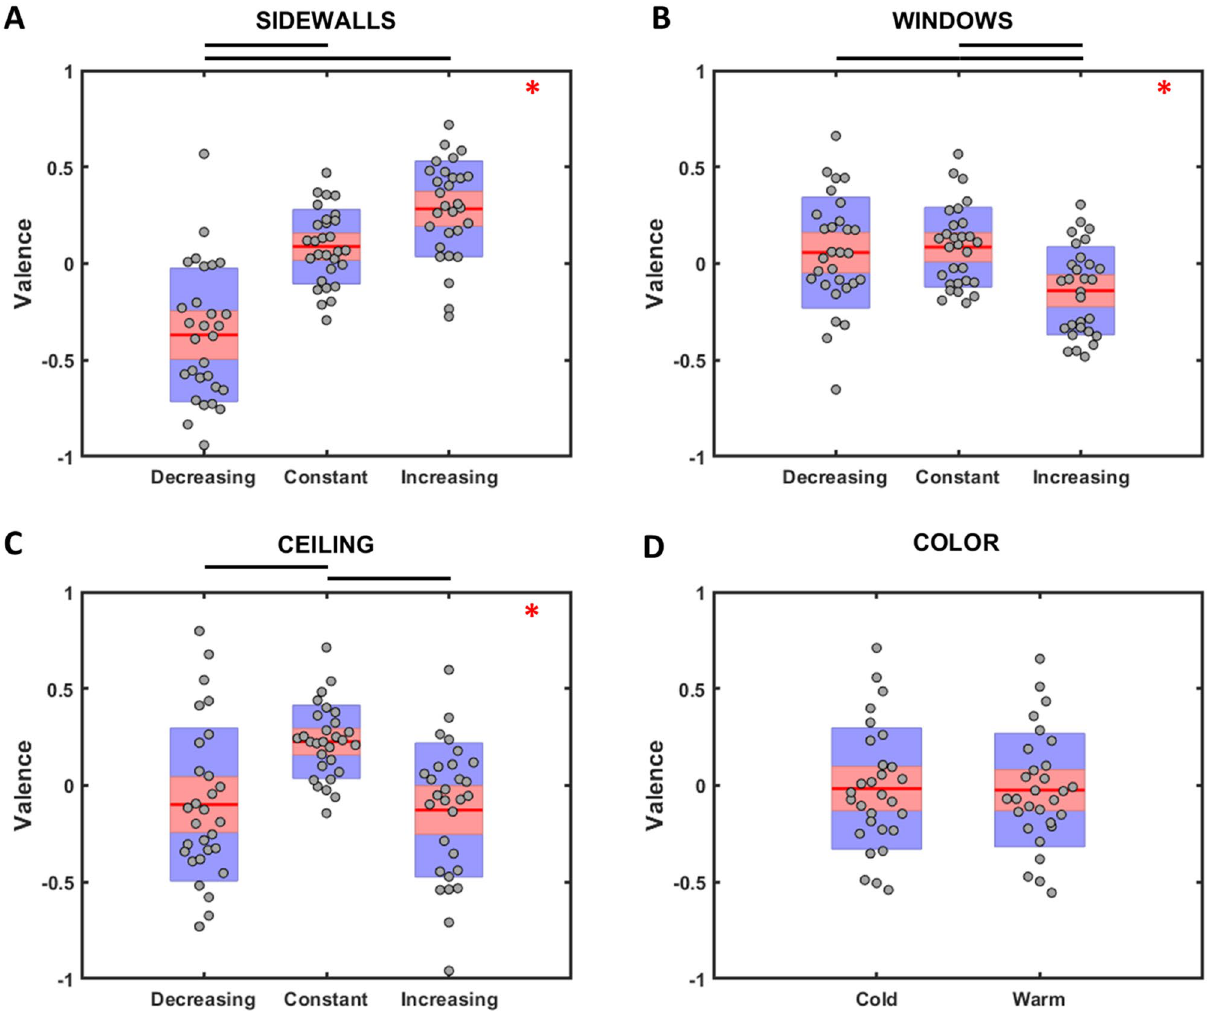
Figure 2. Distribution of the valence scores for SideWalls, Windows, Ceiling, and Color are presented in ( A – D ), respectively. Red lines represent the mean value; data are represented as dots laid over a 1.96 standard error mean (95% confidence interval) in pink and a 1 standard deviation in blue. Red asterisks indicate a significant main effect, and black lines show significant pairwise with different combinations concerning the sidewalls distance and ceiling height. Contrarily, those architectural designs with decreasing sidewalls distance and increasing ceiling height received significantly lower valence scores than those with different combinations of such architectural elements. Also the interaction Windows x Ceiling (F(4,112) = 3.297, p = 0.013, η p2 = 0.105) returned to be significant as presented in Fig. 3B. Specifically, Bonferroni corrected pairwise comparisons revealed that subjects provided significant lower valence scores for those designs with increasing windows height rather than decreasing (p = 0.022) or constant (p = 5 * 10 –5 ), but only when the ceiling of the environment increased between one nucleus and the next one, and not in the decreasing or constant ceiling height condition. Results of the rm ANOVA on arousal ratings are illustrated in Fig. 4. A significant effect was found for the main factors SideWalls (F(2,56) = 20.589, p = 1.9 * 10 –7 , η p2 = 0.424) and Windows (F(2,56) = 6.812, p = 0.002, η p2 = 0.196), with a trend for the factor Ceiling (F(2,56) = 2.519, p = 0.089). Specifically, Bonferroni corrected pairwise comparisons revealed that architectural designs with decreasing sidewalls distance resulted in higher arousal scores than those with constant (p = 2.2 * 10 –4 ) and increasing (p = 1.5 * 10 –7 ) sidewalls distance. Designs with increasing windows sill height were perceived as more arousing than those with constant (p = 0.029) and decreasing ones (p = 0.002). No significant difference among the arousal scores was observed for the factor